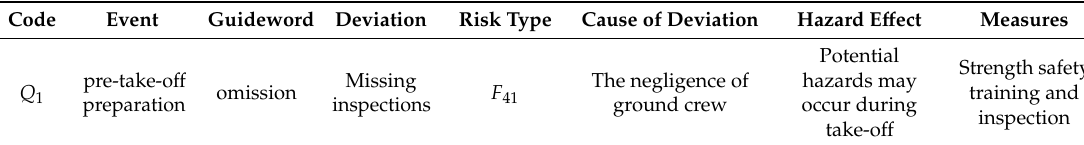
Table 2. The improved hazard and operability analysis